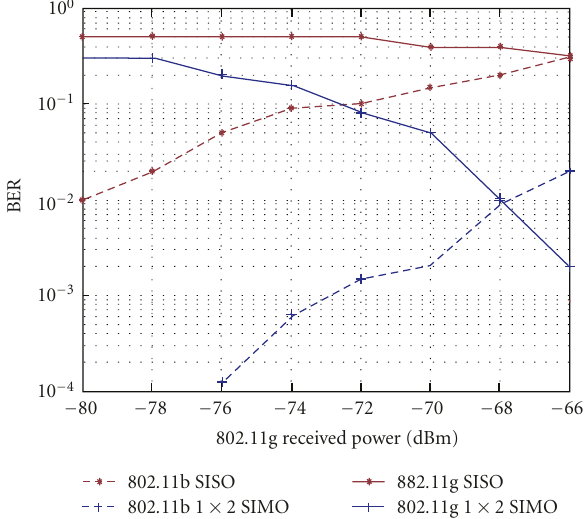
Figure 16: BER depending on 802.11g received power for a channel spacing of 10MHz in a multipath